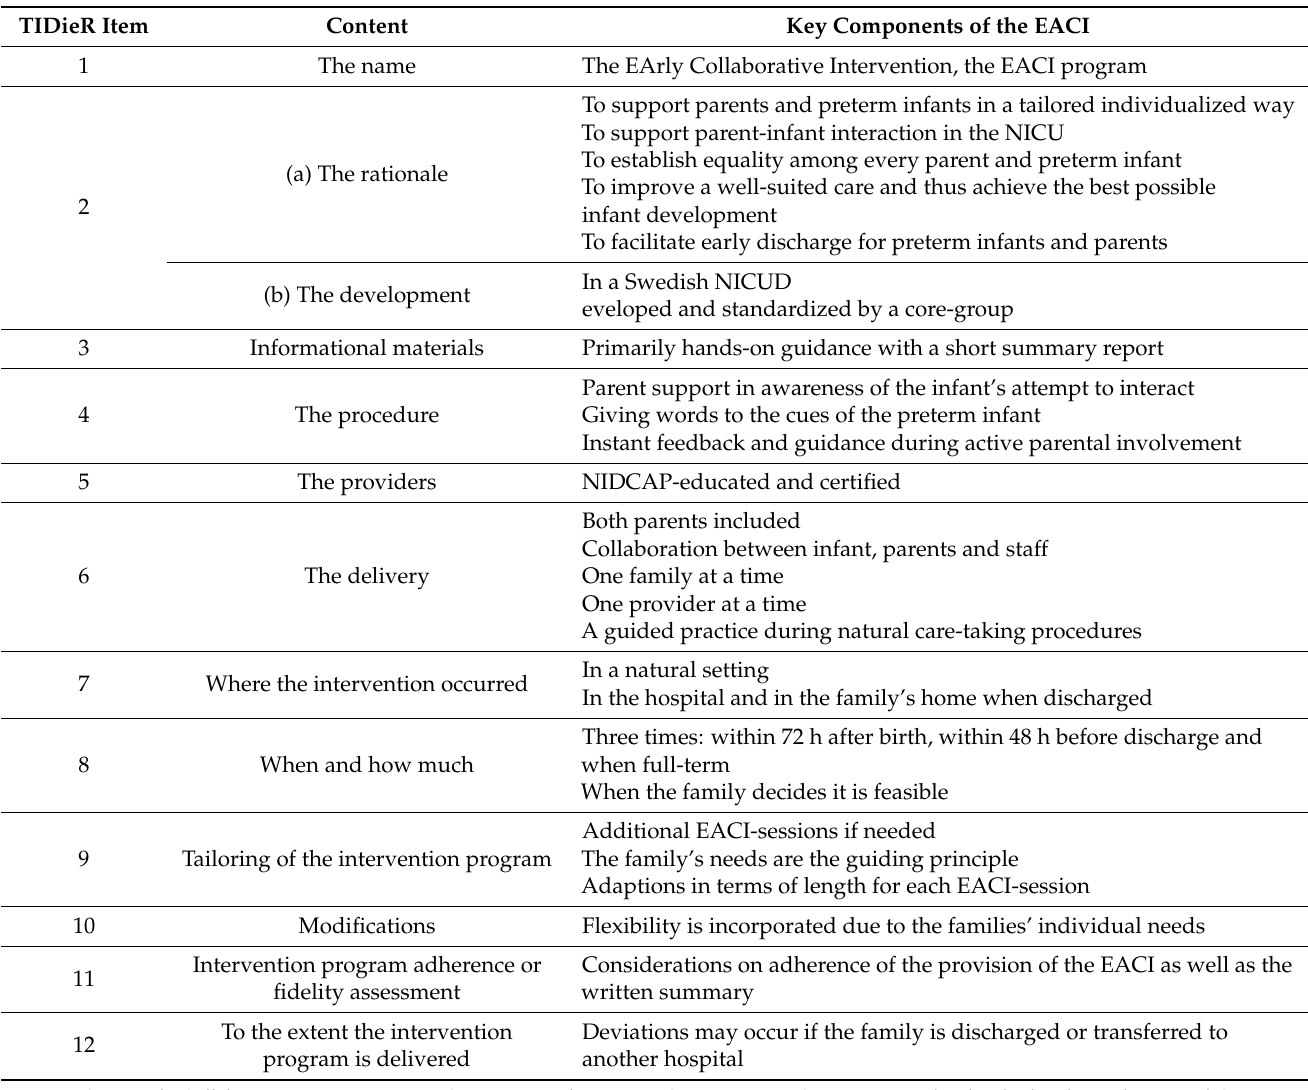
Table 1. TIDieR items and description of the